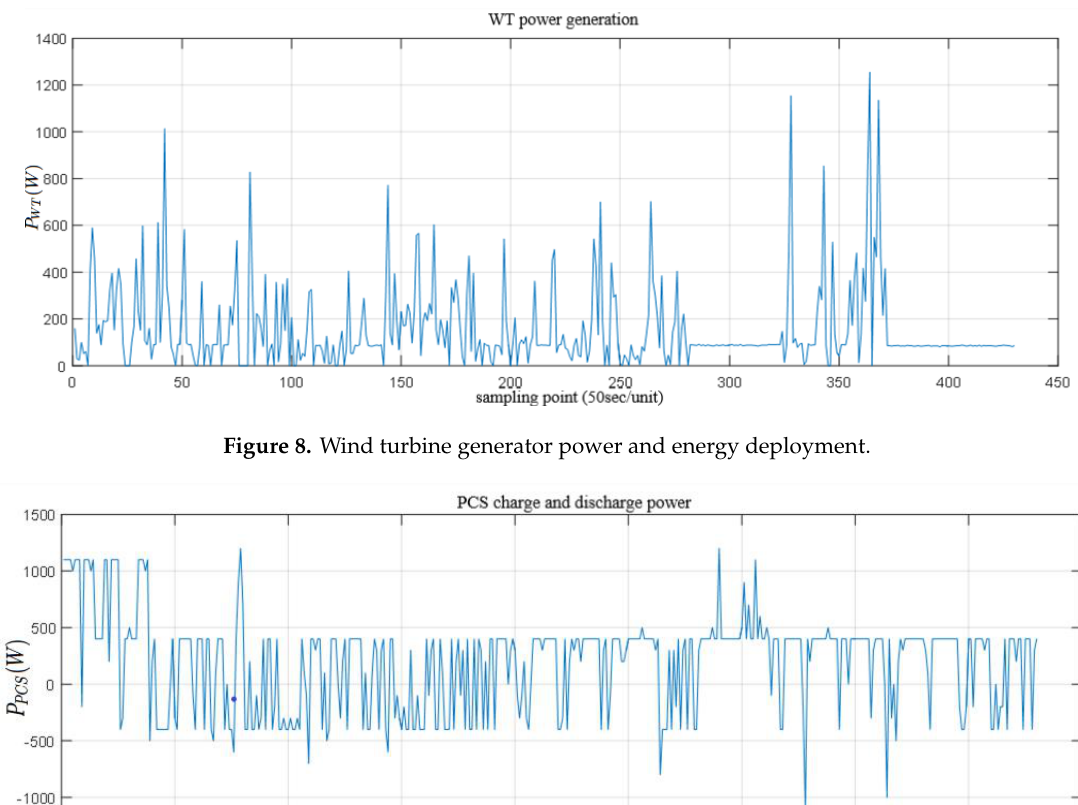
Figure 7. Photovoltaic power and energy deployment.